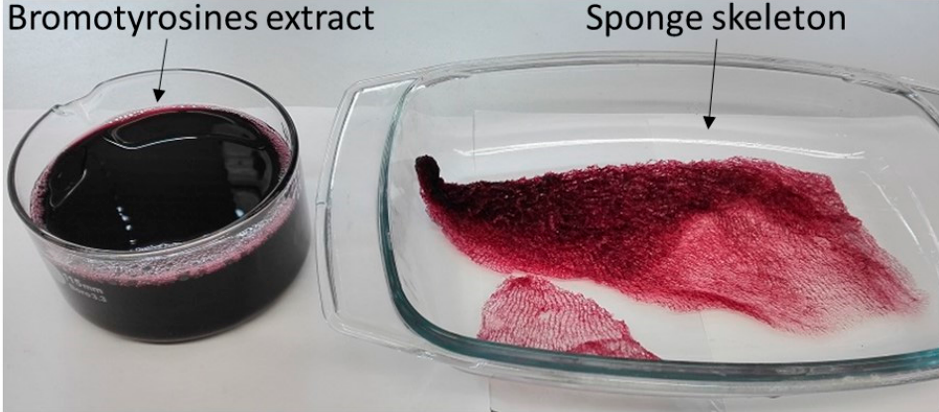
Figure 3. Bromotyrosine-containing extract and bromotyrosine-containing flexible skeleton of I. labyrinthus after 48 h treatment with 2.5 M NaOH at 37 °C.